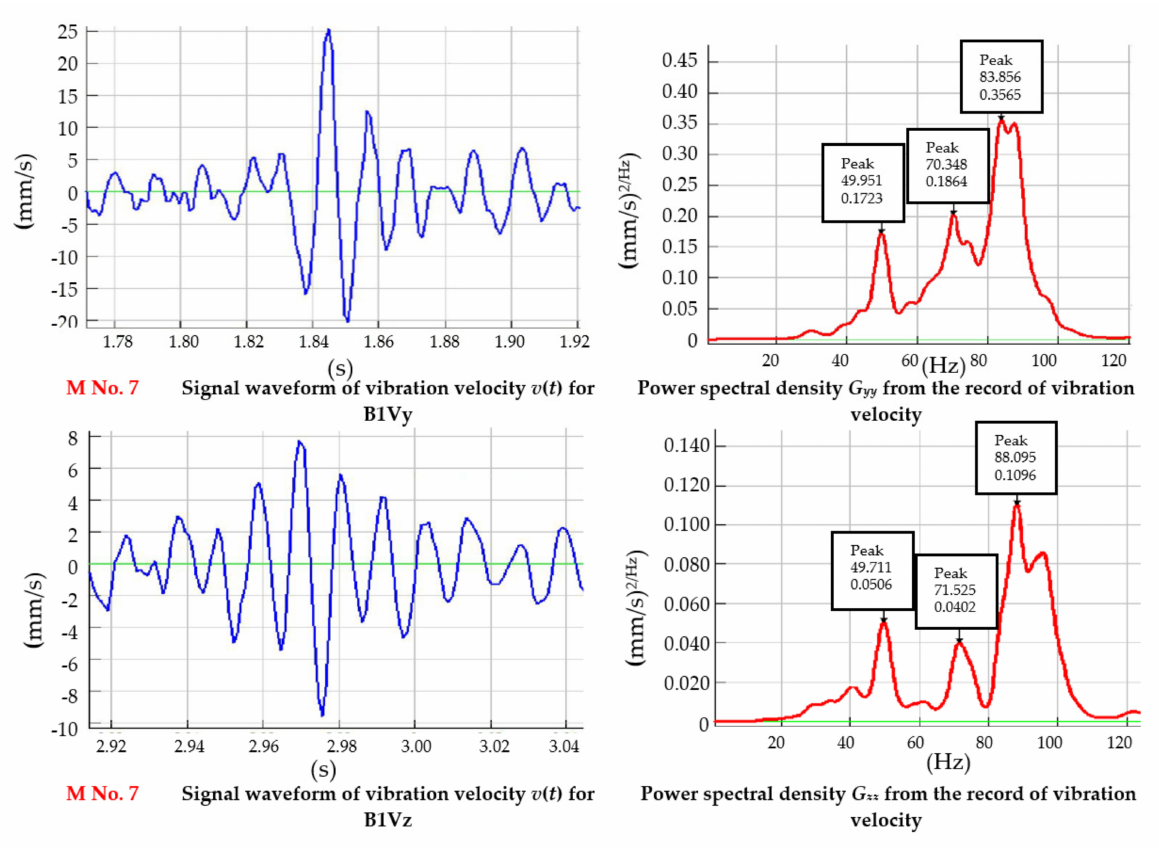
Figure 10. Vibration velocity time history v ( t ) and power spectral density G ii of the vibration velocity recording for measurements for old types of trams.